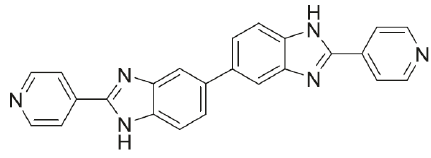
Figure 2. Formula of